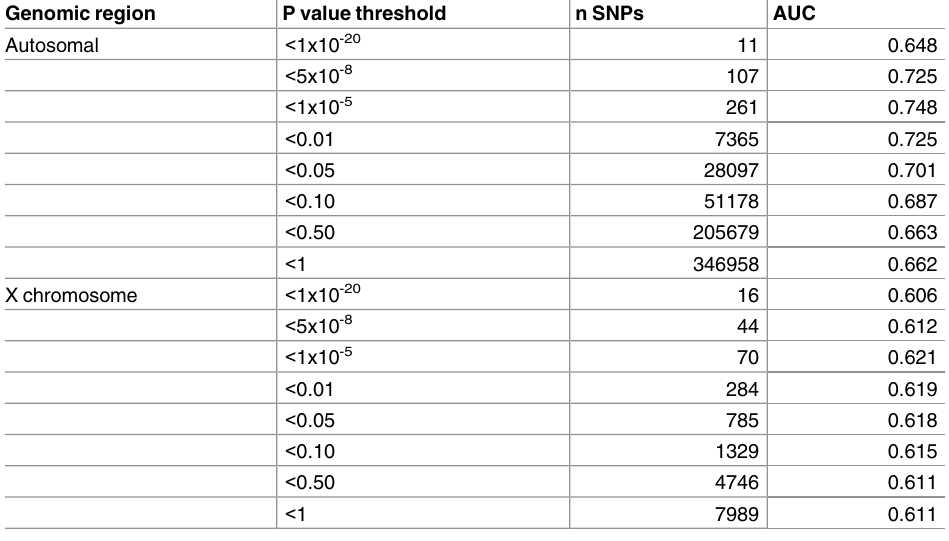
Table 3. AUC results for severehair loss versus no hair loss for all autosomal and X chromosome polygenic